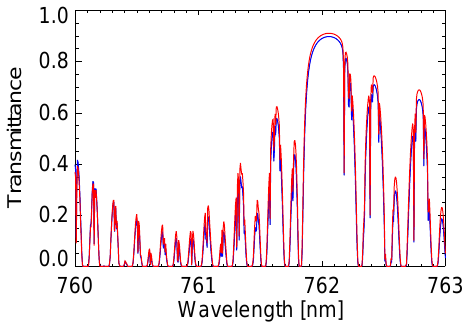
Figure 3: Global transmittance t O for GFS temperature profiles, a constant sur- 2 A face pressure of 1000hPa, solar zenith angle of 45° and nadir view. Fig. 3. Global transmittance t O for GFS temperature profiles, a 2A t O for GFS temperature profiles, a constant sur- constant surface pressure of 1000hPa, solar zenith angle of 45 ◦ and 2 A face pressure of 1000hPa, solar zenith angle of 45° and nadir view. nadir view.